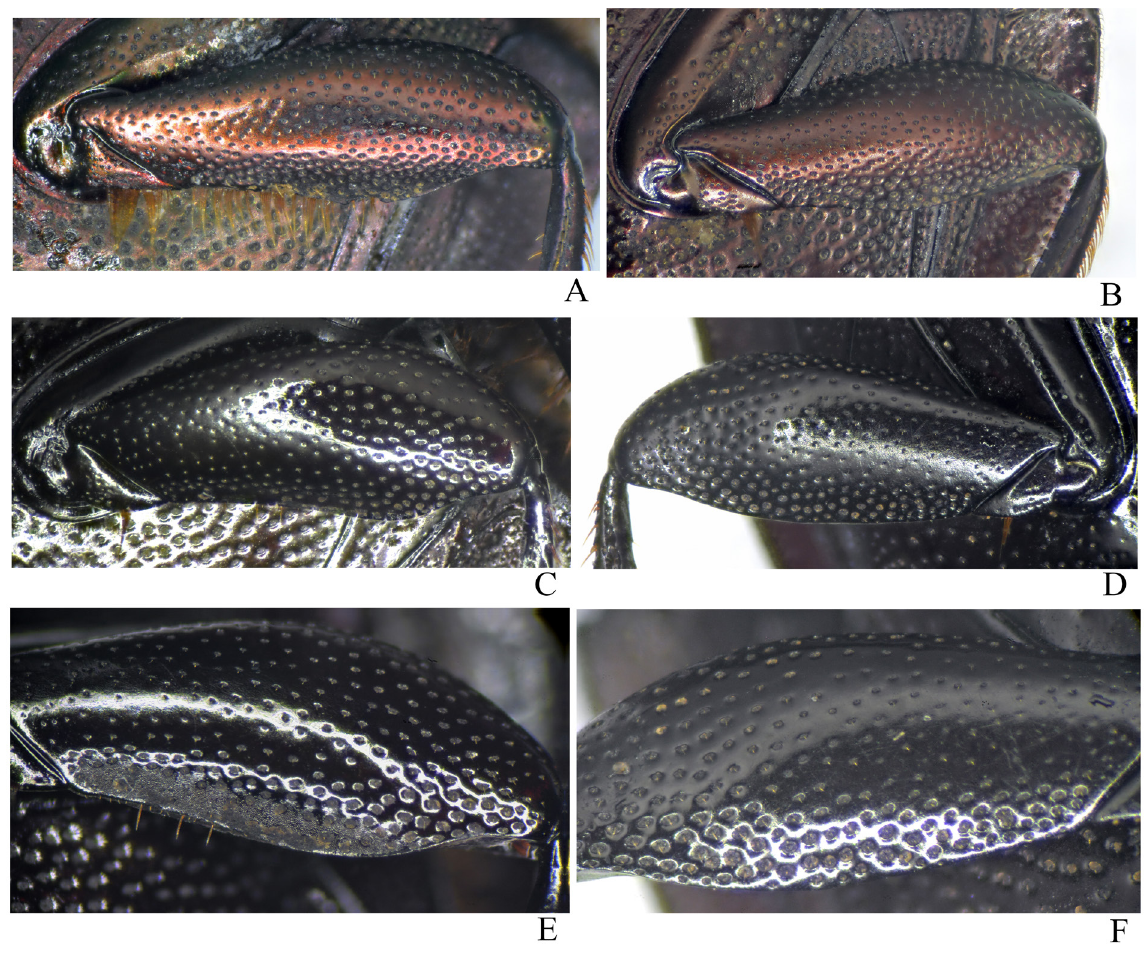
Fig. 17. Mesofemora. A‒B . Streblopus opatroides van Lansberge, 1874. A . ♂. B . ♀. Note the sexual dimorphism in the presence of a long row of setae on the posterior edge of the male mesofemur. C‒F . S. punctatus (Balthasar, 1938). C . ♂. D . ♀. E‒F . Detail of posterior region of metafemora. E . ♂. F . ♀. Note the strong alveolar microsculpture present near the posterior edge in males and the high concentration of umbilicate punctures in the same region in